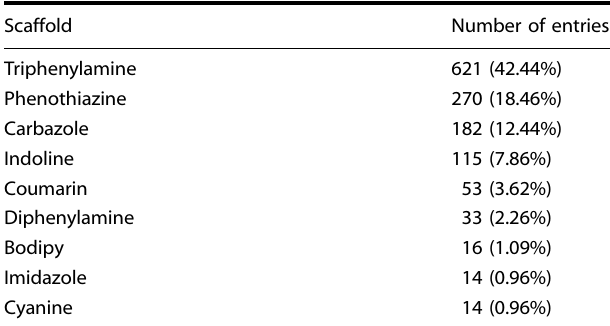
Table 1. Signi fi cant chemical families in the preprocessed DSSCDB and their